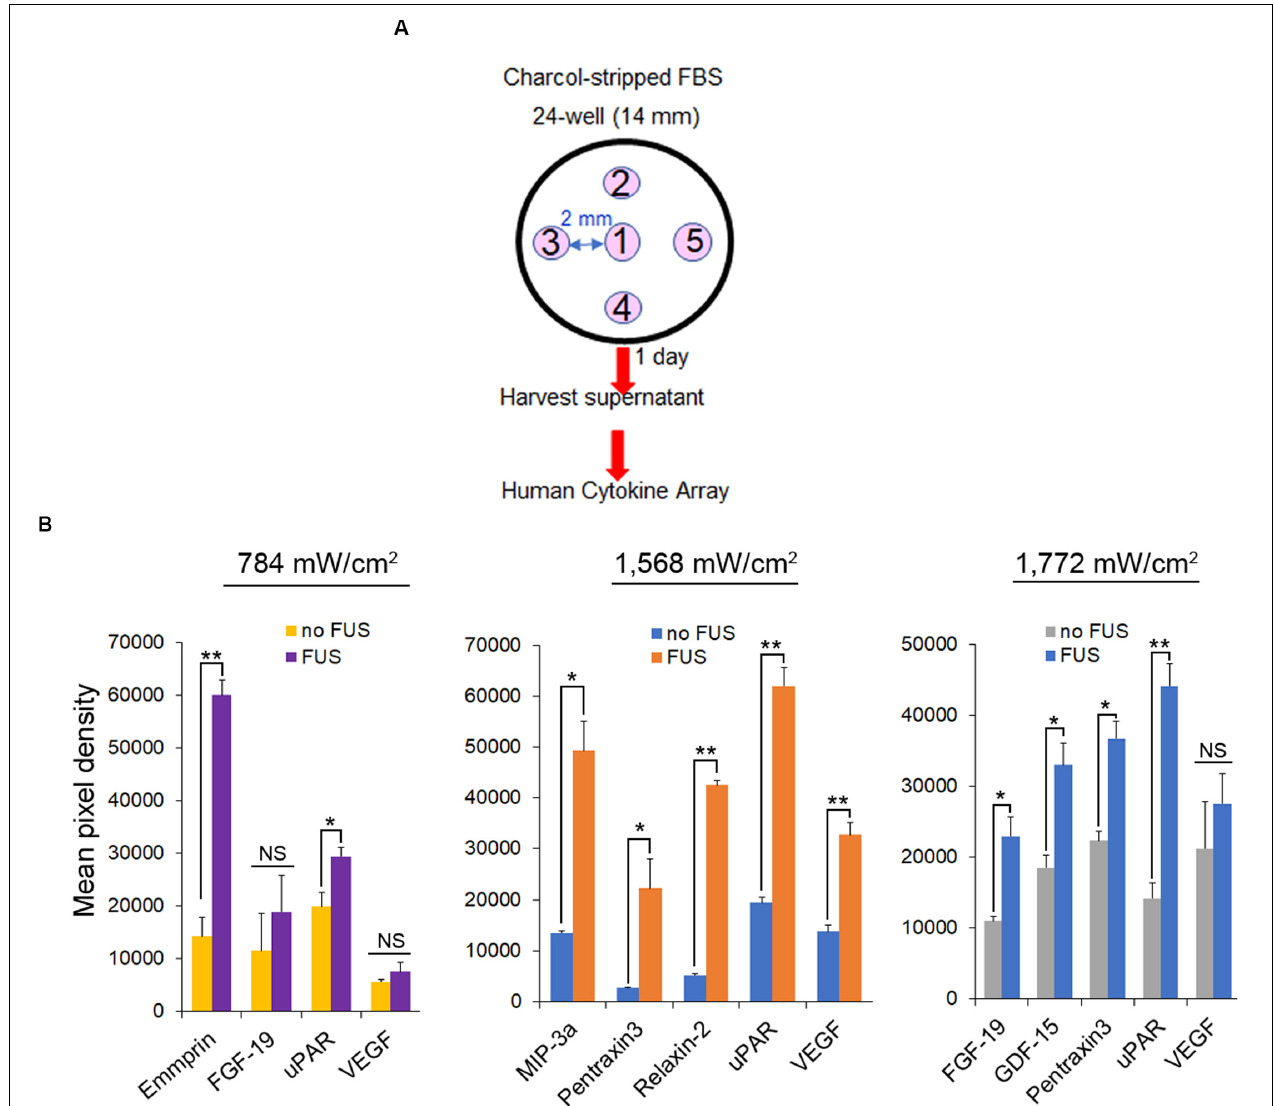
FIGURE 8 | Cytokine and chemokine secretion from PC-3 cells following different intensity of FUS stimulation. (A) Protocol for FUS stimulation and a human cytokine array. (B) Cytokine and chemokine secretion from PC-3 cells following different intensity of FUS stimulation. n = 2. Error bars, s.e.m., NS, not significant, * P < 0.05; ** P < 0.01 by a one-tailed t